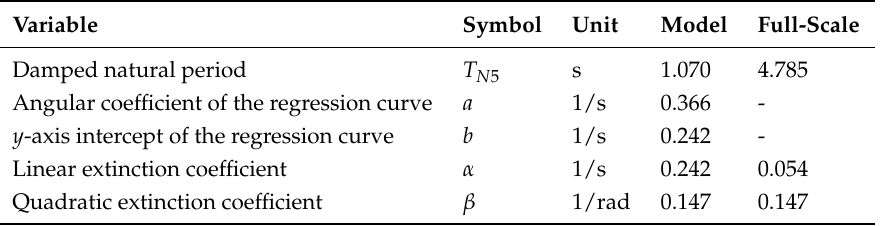
Figure 6. ISWEC pitch decay curve. Table 2. ISWEC full-scale and scaled prototype